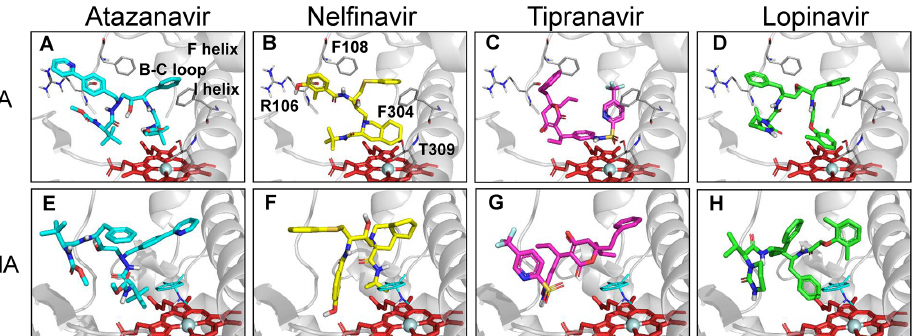
Fig 5. Docking simulations of PIs in the absence and presence of methamphetamine. Structures of (A) Atazanavir, (B) Nelfinavir, (C) Tipranavir and (D) Lopinavir with their preferred binding sites pointing towards the heme moiety of CYP3A4in the absence of methamphetamine. Docking simulations of (E) Atazanavir, (F) Nelfinavir, (G) Tipranavir and (H) Lopinavir with heme moiety of CYP3A4 in the presence of methamphetamine. R-methamphetamine in binding mode 1 was shown in cyan sticks. Docking was performed as described in Materials and Methods.